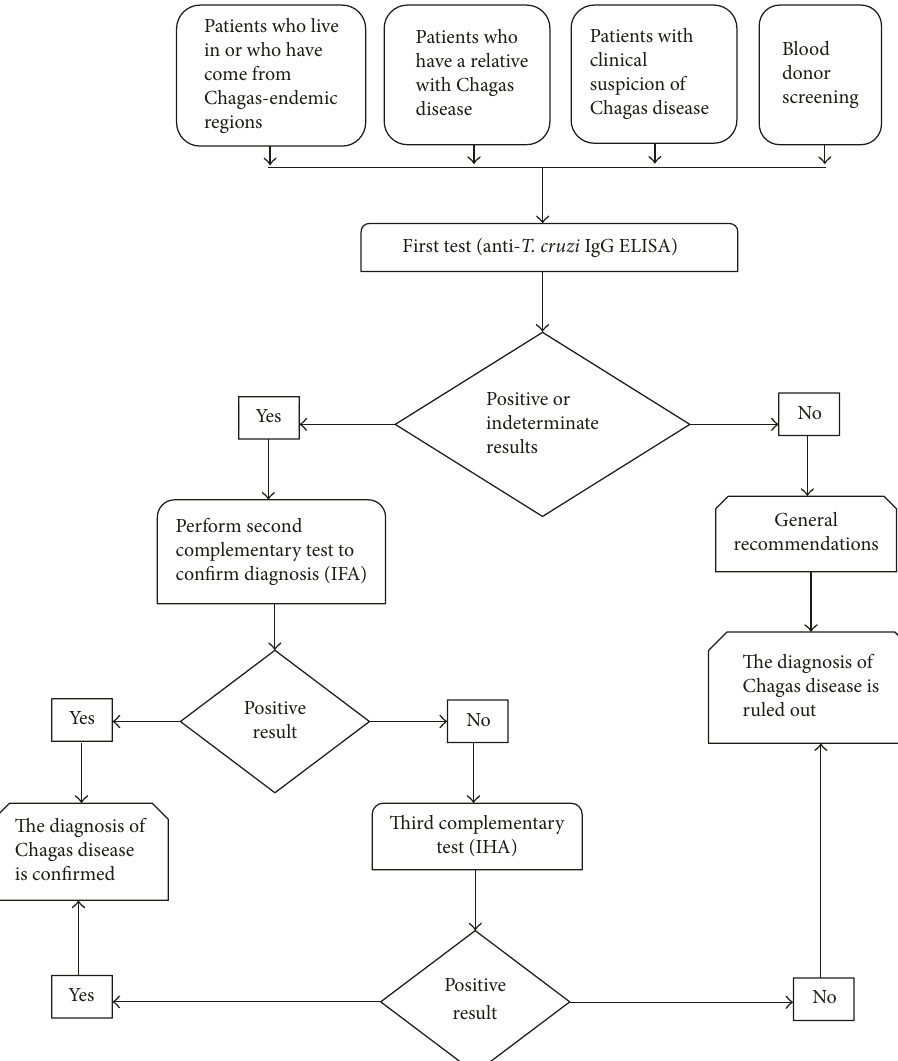
Figure 2: Generalized flow diagram of Chagas disease diagnosis in